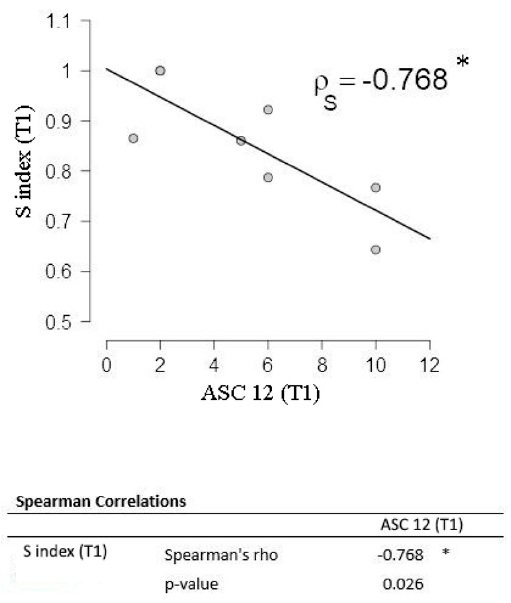
Figure 4. S index correlation with Allodynia Symptoms Check-list 12 (ASC-12) is confirmed at follow-up (T1). * p <